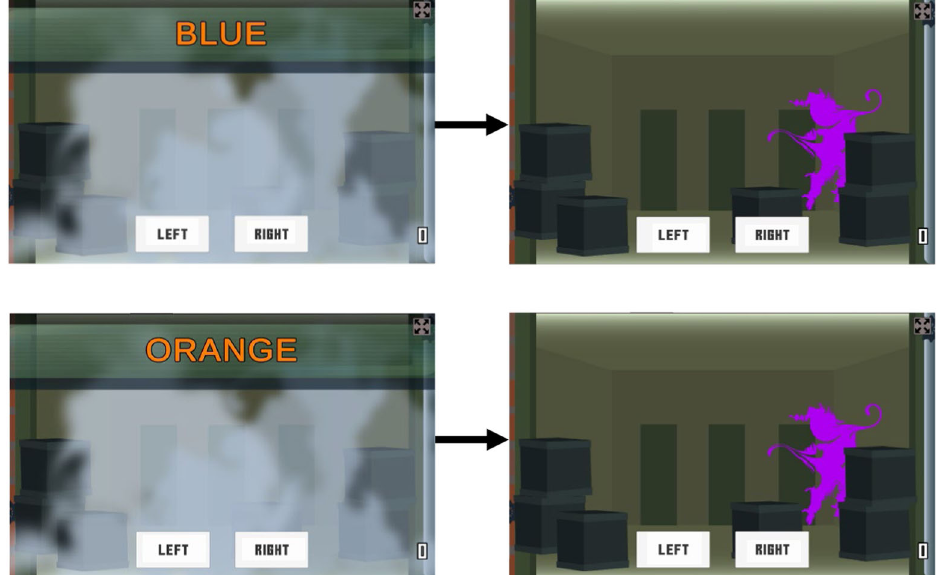
Fig. 2 | Illustrations of the Stroop task with double-shot. Stimuli are colored words presented in the middle of the display and a response is based on the color thetextiswrittenin.Thetopexampleshowsanincongruenttrialwherethecorrect responseisorange(orright,iforange=respondrightandblue=respondleft).The